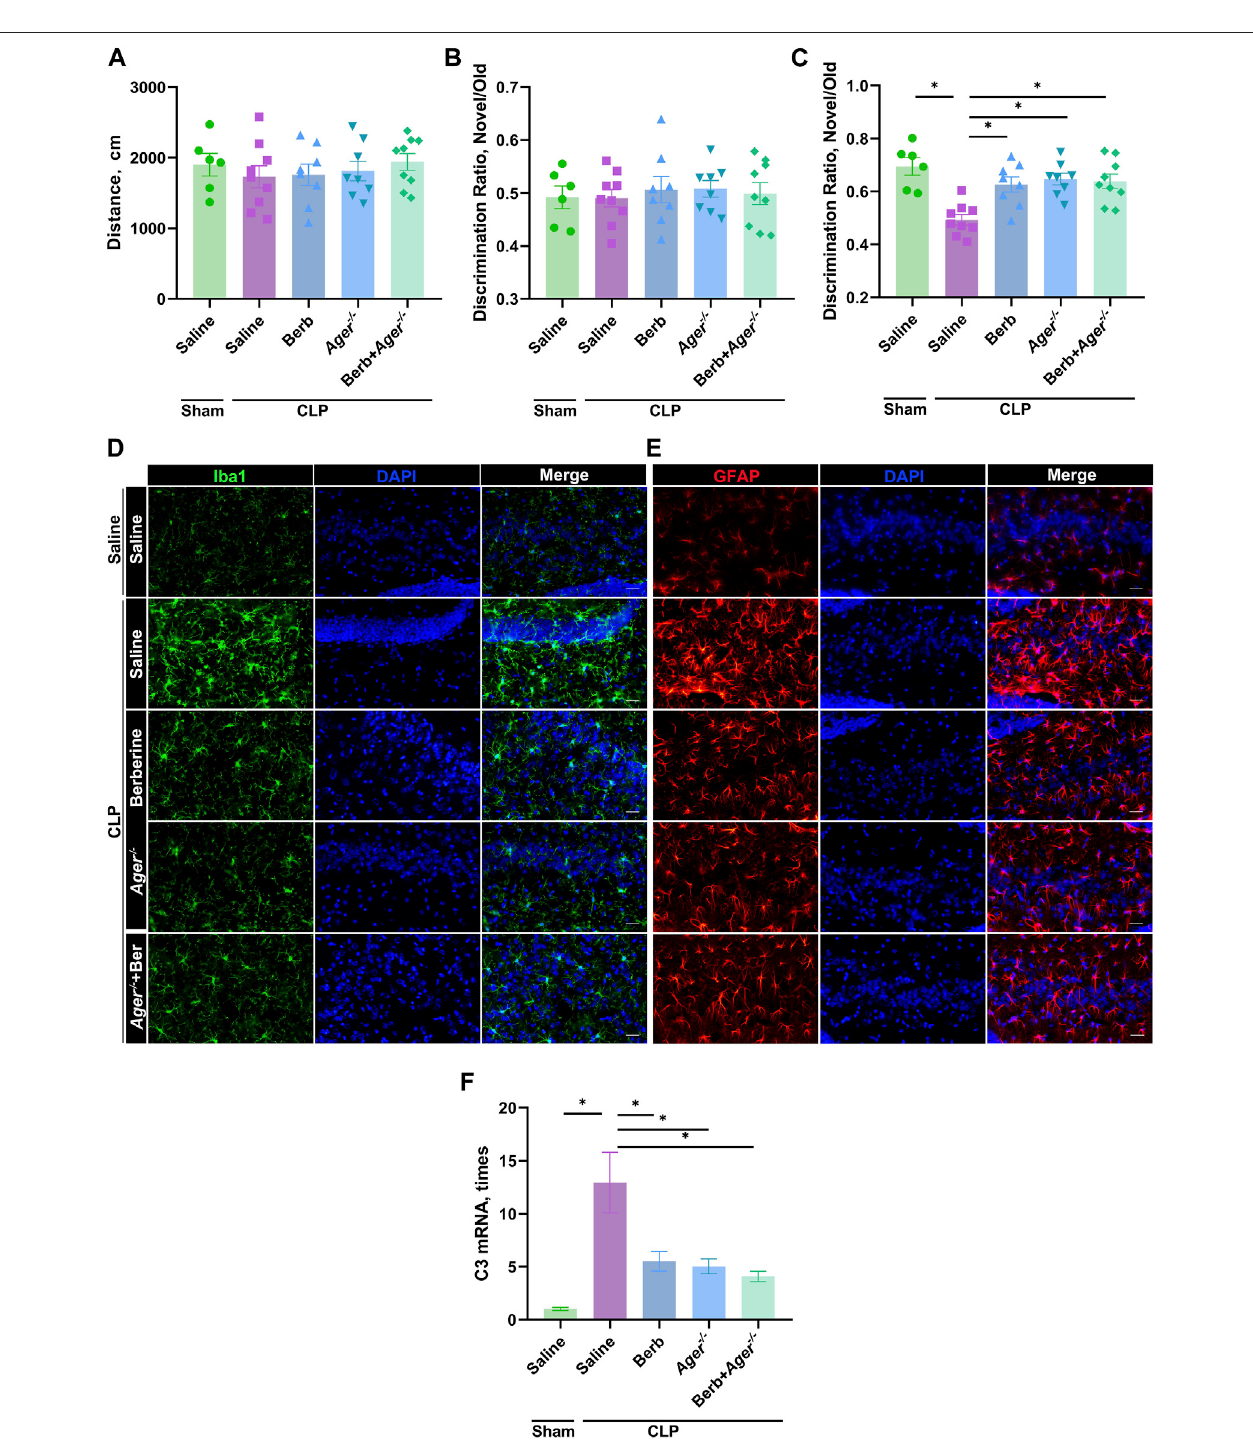
FIGURE4| Berberineimprovesepsis-associatedencephalopathybyinhibitingHMGB1/RAGEsignaling. (A – F). Ager − / − orWTmicewereadministratedwithsaline or berberine (10 mg/kg) 30 min priortoachallenge ofcecalligationand puncture. TravelingdistanceinOpen Field Test (A) ,discrimination ratiooftraining phase (B) and testphase (C) inNovelObjectRecognition( n (cid:2) 6,9,8,8,9,respectively). (D) and (E) .Immuno fl uorescentstainingofmicroglia(Iba1,Green,400 × )andastrocytes(GFAP, Red,400 × )inthehippocampusofmice(Scalebar (cid:2) 100 μ m). (F) C3expressionlevelsinthehippocampusofmice*indicates p < 0.05inthecomparisonsofsaline- treated CLP group with other groups.